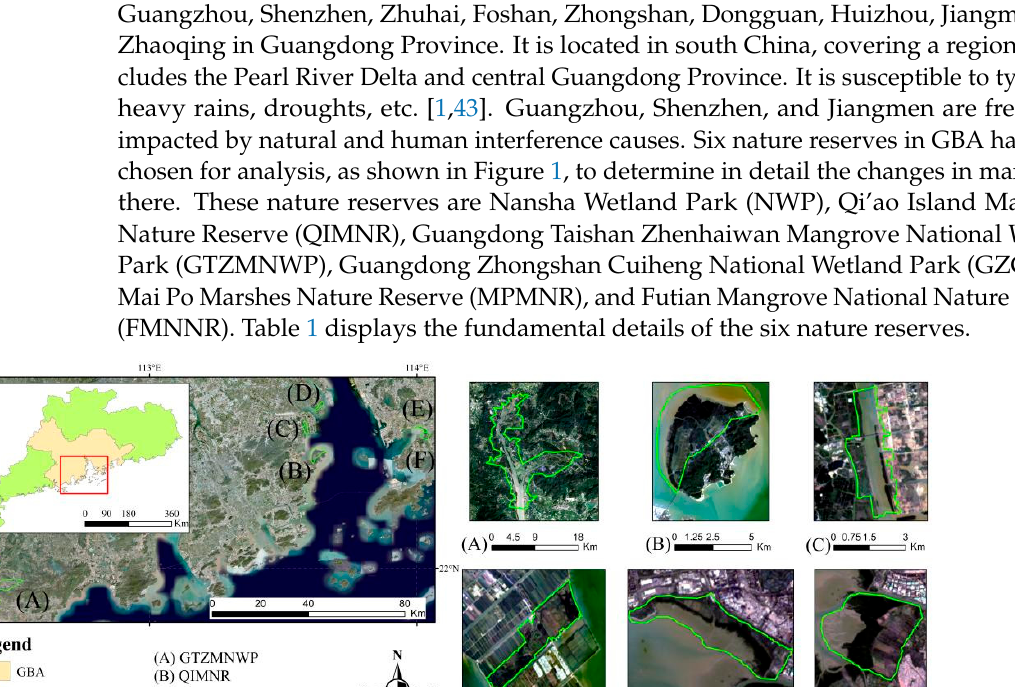
Table 1. Overview of the features used for mapping terraces.